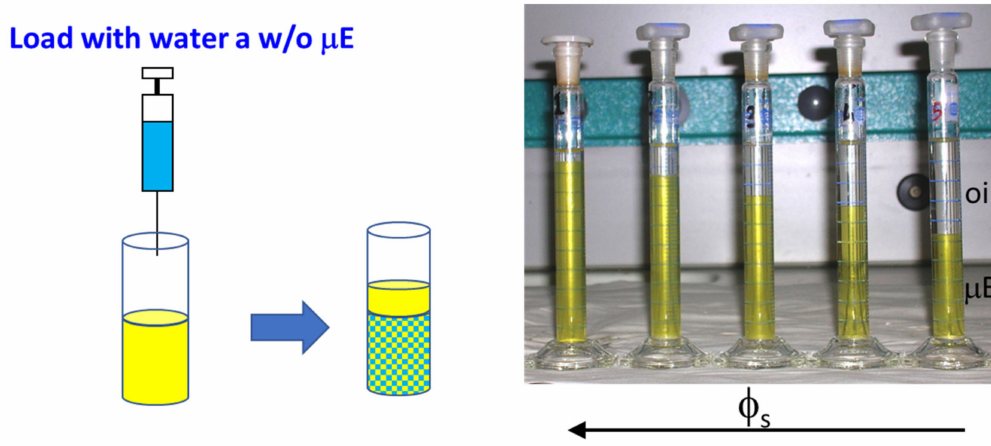
Figure 6. In the example on the left, an asymmetric bicontinuous µ E is loaded with tiny amounts of water. Above a certain water content, the system phase separates into a dense (and viscous) µ E in equilibrium with oil. On the right, in the case of the system water / soy-bean lecithin / pentane, the phase separation takes place for molar ratio water / lecithin = 7; the test tubes represent a series of samples at a constant molar ratio of water / lecithin = 7 and di ff erent φ s ranging from 0.03 ( right ) to 0.08 ( left ). For φ s > 0.115, the system does not phase